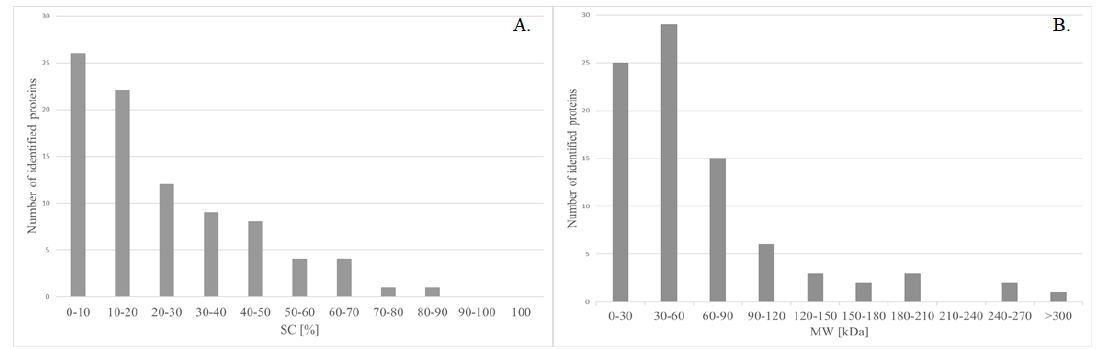
Figure 2. Distribution of all identified proteins in mass spectrometry analysis based on ( A ) Sequence Coverage ( B ) Molecular Weight.